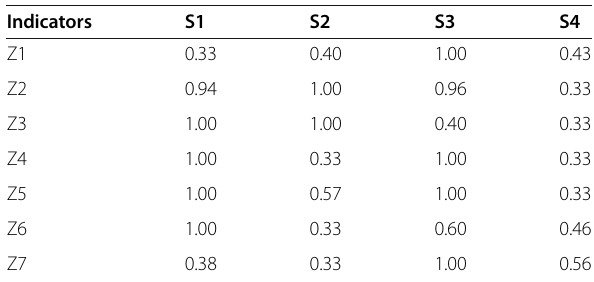
Table 14 Grey Correlation Coefficient of Normalized Data and Reference Sequence (Source: authors)